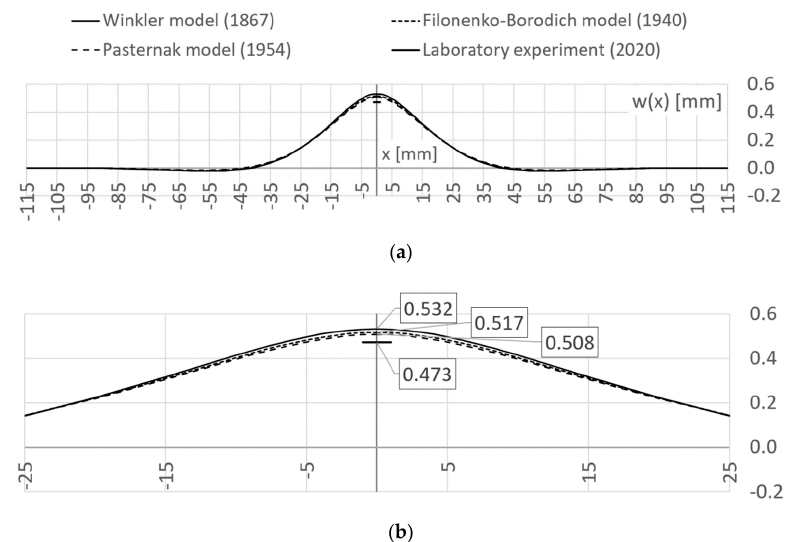
Figure 11. Displacement lines of the pull-out of the blind rivet obtained from analytical models and from the experiment: ( a ) whole displacement line, ( b ) zoomed range.